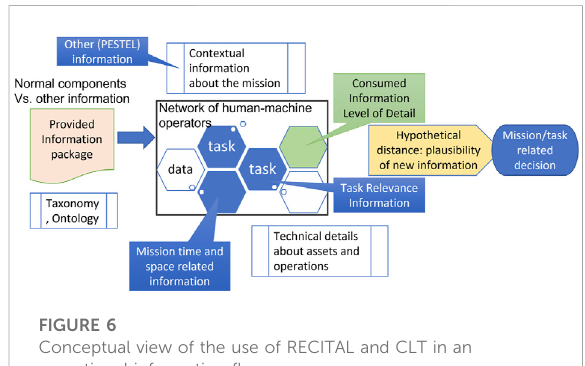
Conceptual view of the use of RECITAL and CLT in an operational information fl